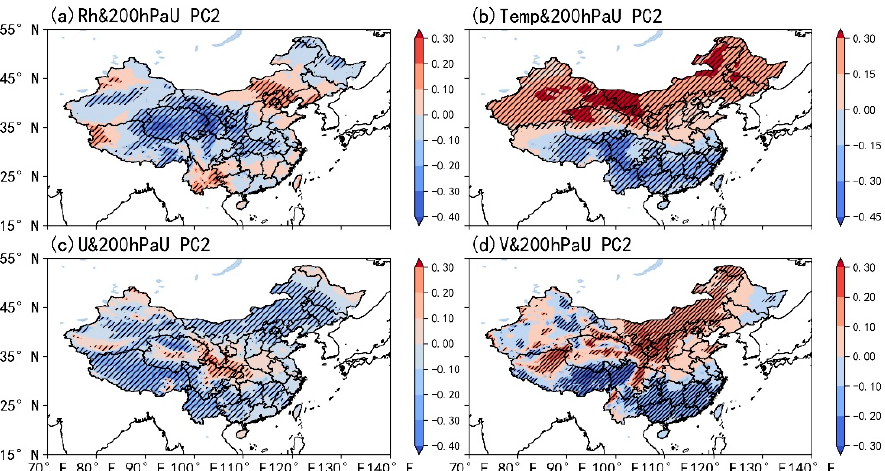
Figure 13. The correlation coefficients between the time series of the EOF2 of the 200 hPa zonal wind and surface meteorological variables of the ( a ) humidity, ( b ) temperature, ( c ) surface zonal wind and ( d ) surface meridional wind in summer during 2013–2018. The slashes indicate that the results passed the 95% Monte Carlo correlation test.